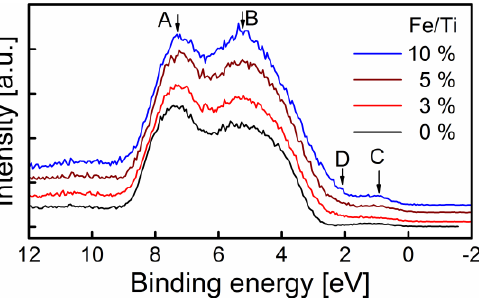
Figure 11. Valance band for TiO 2 and Fe-doped TiO 2 samples, indicating structures A, B, and C for TiO 2 and structure D for Fe.